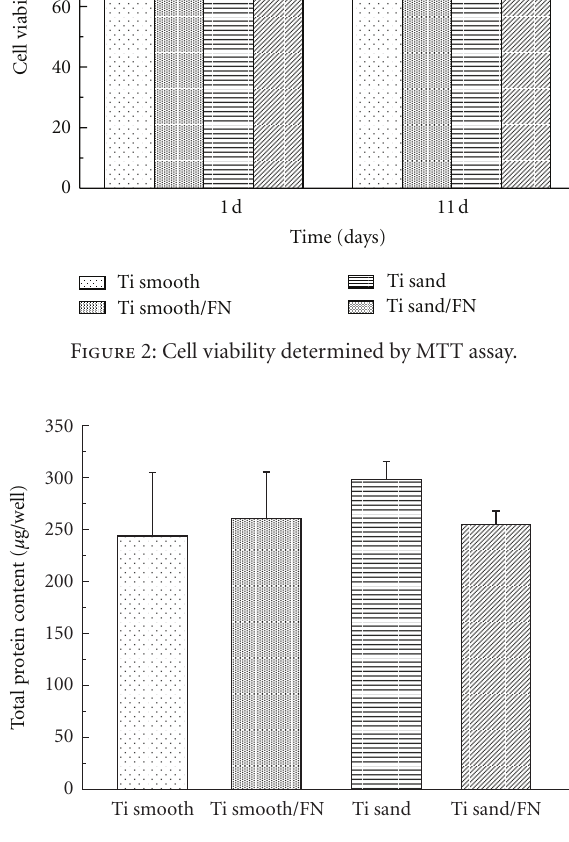
Figure 3: Total protein